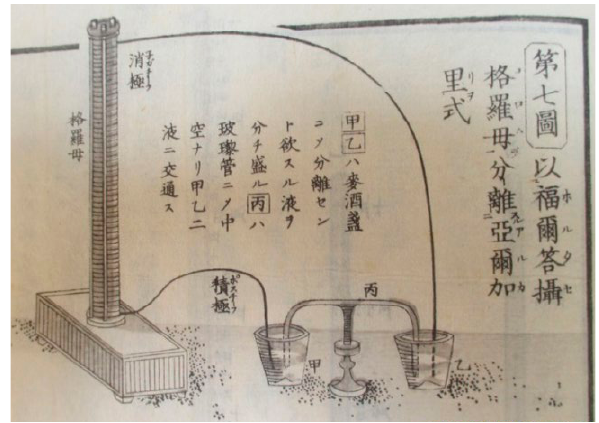
Figure 6. Youan’s Volta pile sketch and explanation. SK book 1, vol. 3 Figure 7. Photo: Y.